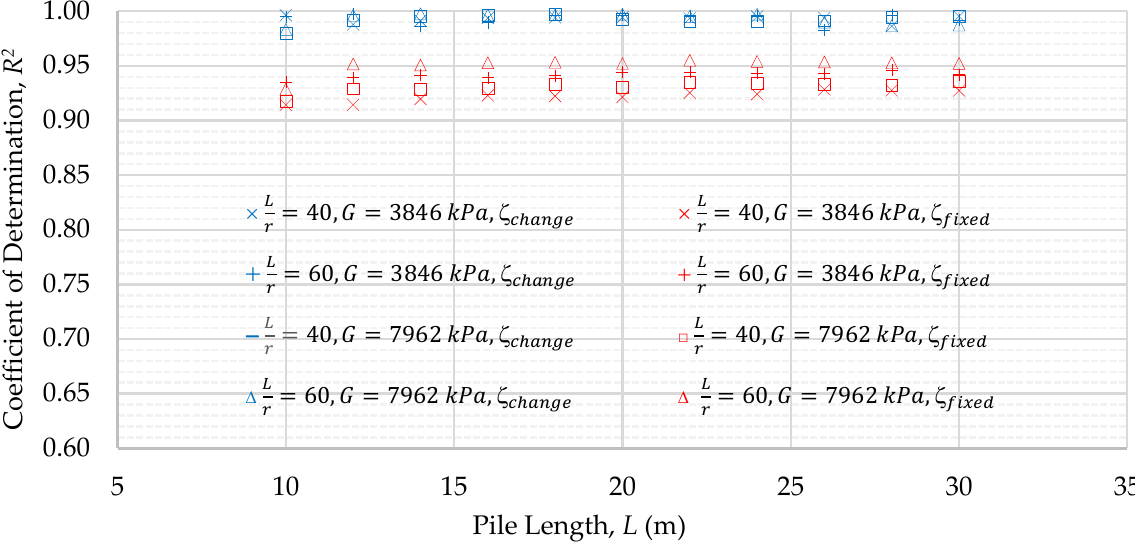
Figure 16. Coefficient of determination ( 𝑅 2 ) of load–displacement curves versus pile length (analytical against FE analysis results).